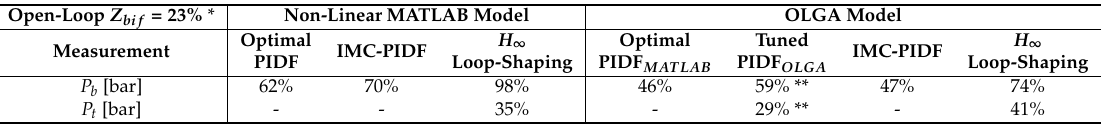
Table 8. Controller comparison between P b and P t with optimal PIDF, IMC-PIDF and H ∞ loop-shaping control schemes. The table’s result entries show the absolute maximum stable choke opening indicating the closed-loop bifurcation point for each controller